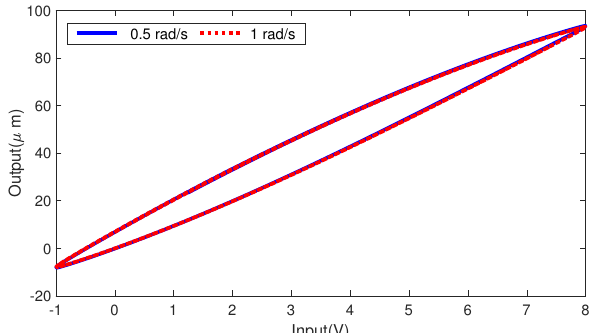
Figure 1. Hysteresis loops with sinusoid signal inputs of 0.5 rad/s and 1 rad/s.